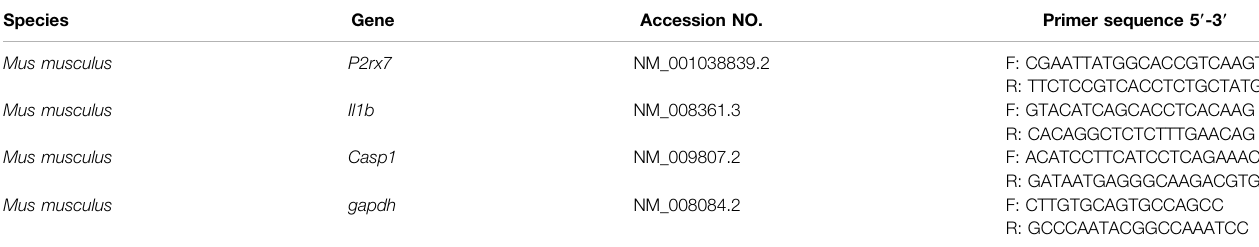
TABLE 1 | Primer sequences used for RT-PCR Species Gene